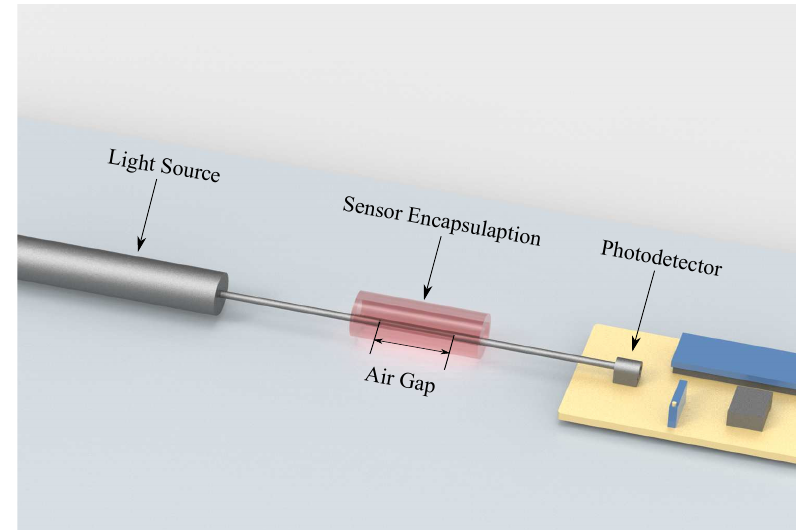
Figure 5. Configuration of optical-fiber strain gauge based on light-coupling principle. Sensor is composed of two fibers, transmitter attached to the light source and receiver attached to the photodetector. In the presence of axial displacement, there is an increment of the air gap that leads to power